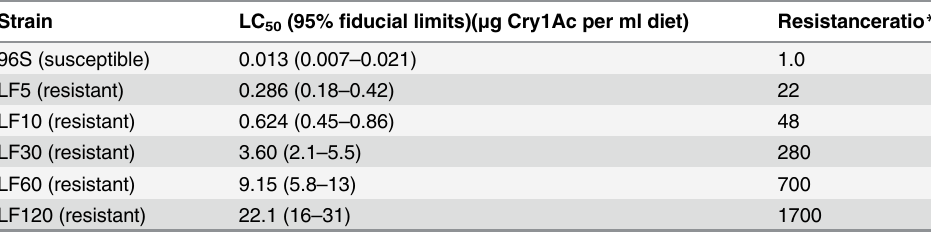
Table 1. Susceptibility of H . armigera strains to